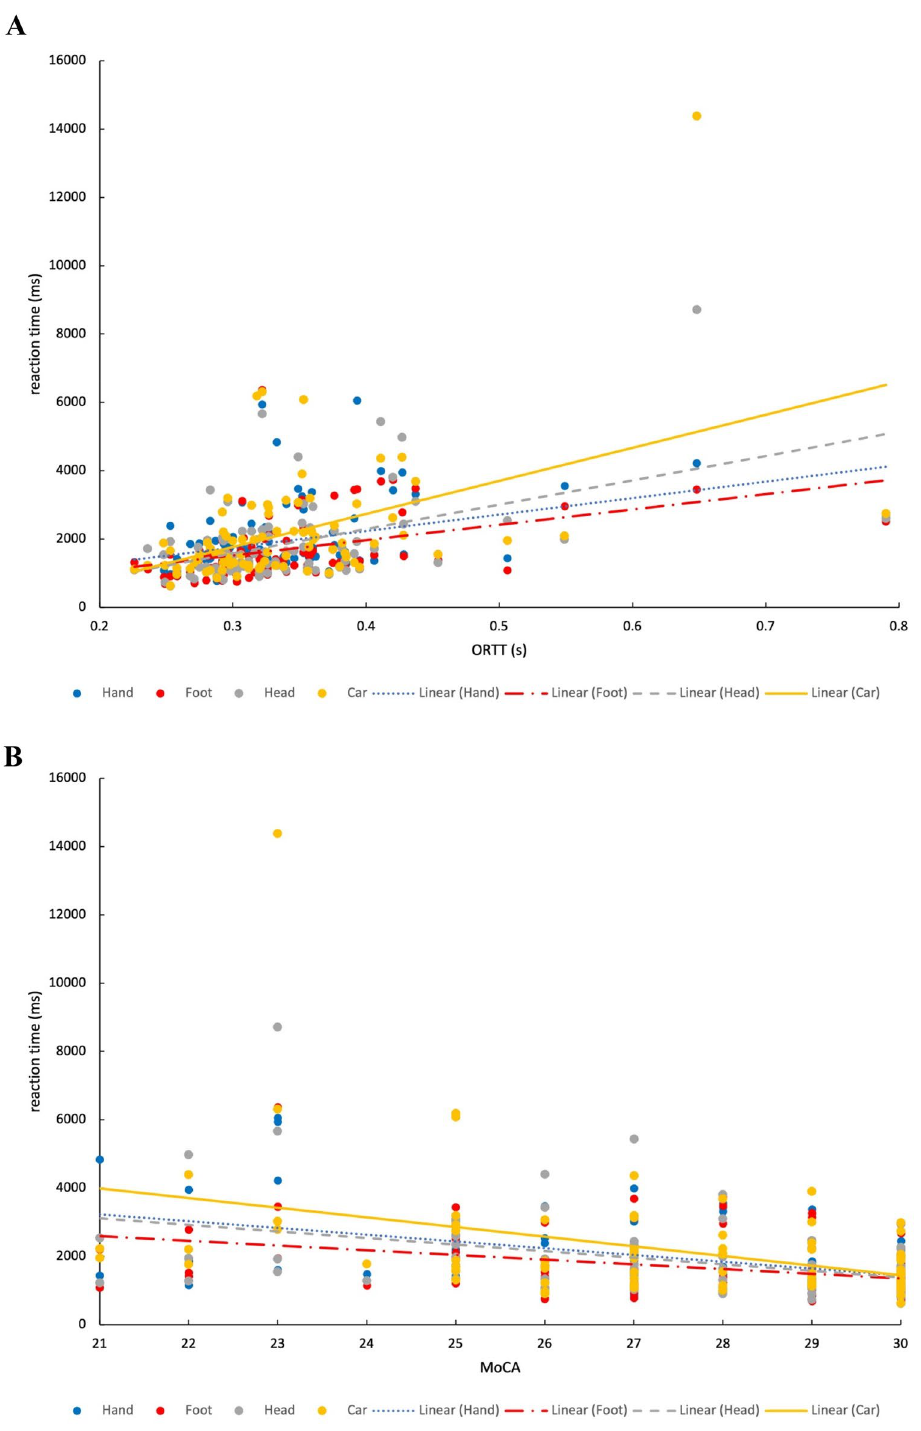
Figure 3. ( A + B ) Correlation between mean reaction times of ( A ) Online Reaction Time Test (ORRT) and B MoCA score with Mental Rotation of all stimuli (hand, foot, head, car). Footnote: the correlation remains positive, when removing outliers (mR RT > 7000 ms) from the